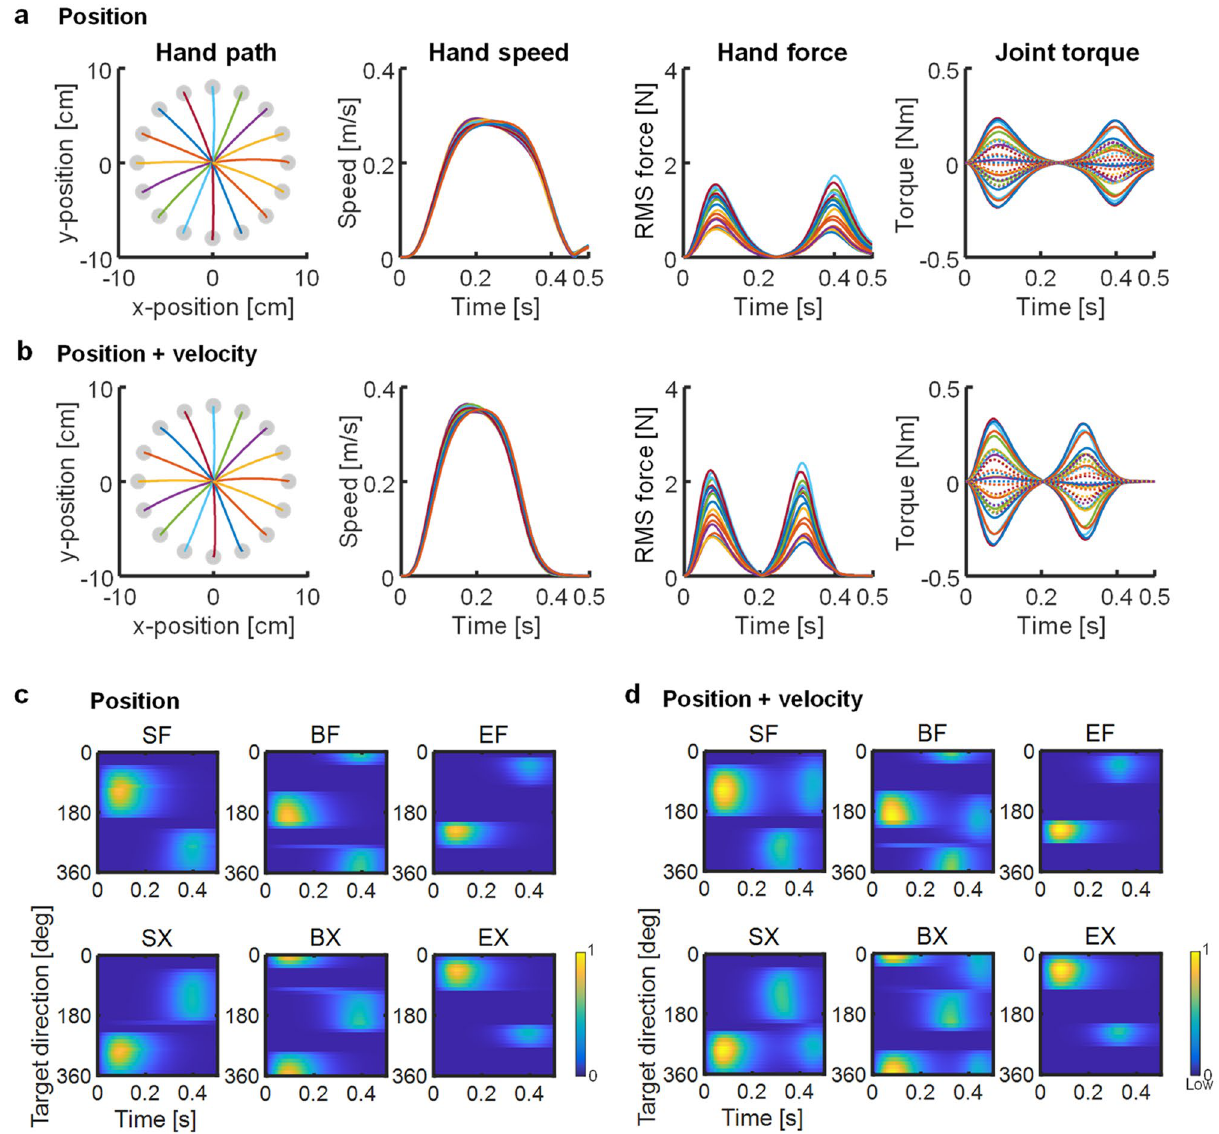
Figure 5. Stabilisation control. Controls of position cost and two position and velocity costs are shown in ( a , c ) and ( b , d ), respectively. ( a , b ) Centre-out movement for 16 targets. The format is identical to Fig. 2. ( c , d ) Muscle activation pattern. The format is identical to Fig. 3. Muscle activation levels were normalised by the highest activation level in each muscle across both cases: SF, 0.31; SX, 0.33; BF, 0.23; BX, 0.23; EF, 0.27; EX,